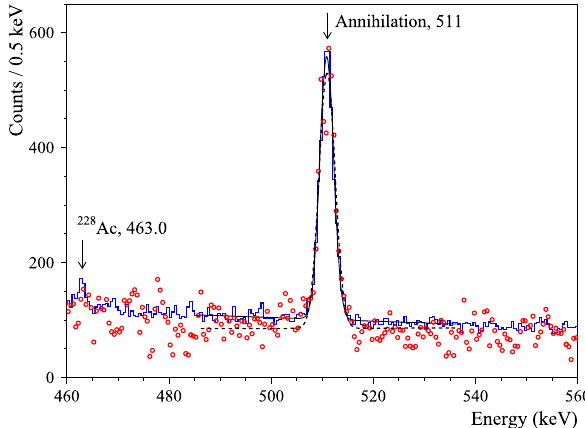
Fig. 10 The energy spectrum measured with the Pt sample for 8946 h in the vicinity of the 511 keV annihilation peak. The background data (measured over 674 h, normalized on 8946 h) are shown by dots. The fit of the data obtained with the Pt sample is shown by solid line, the fit of the background spectrum is presented by dashed